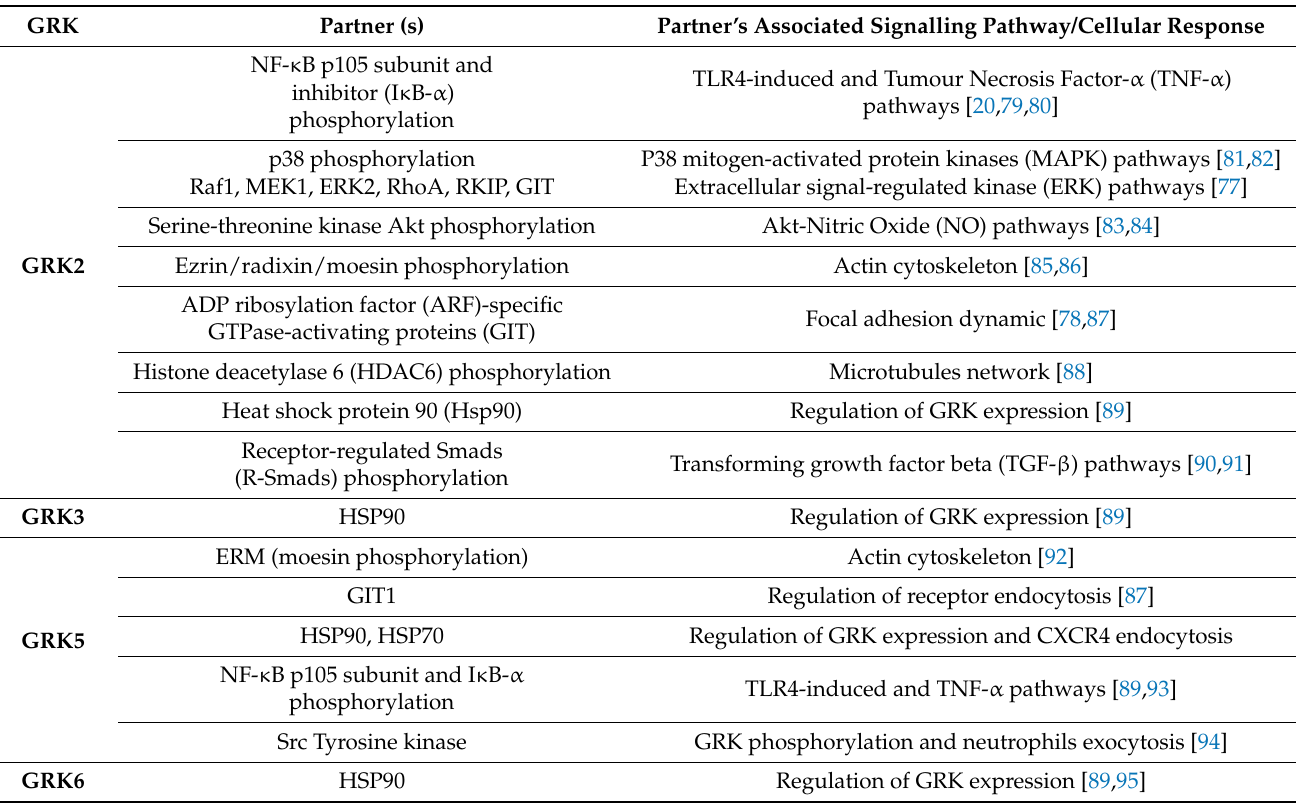
Table 2. GRK partners and their functions in immune cells and inflammation.